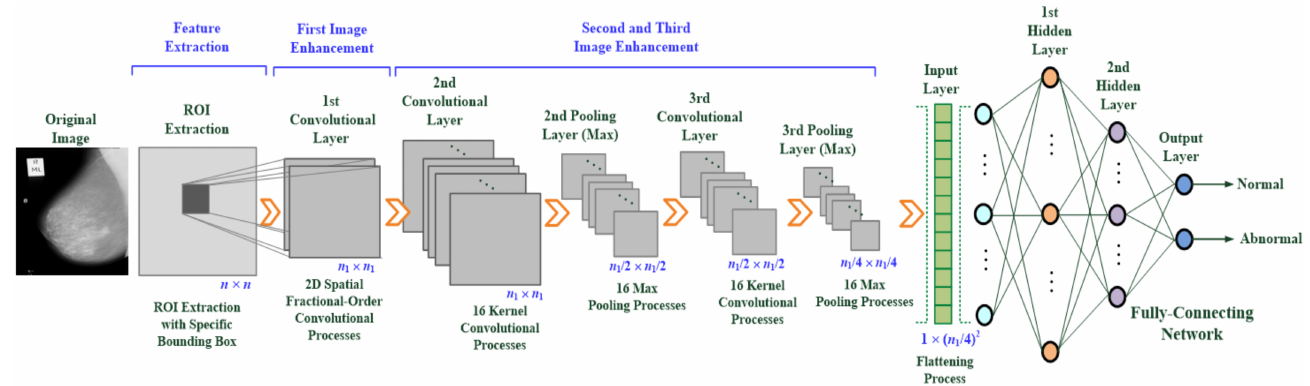
Figure 1. Architecture of the proposed multilayer CNN for automatic breast tumor